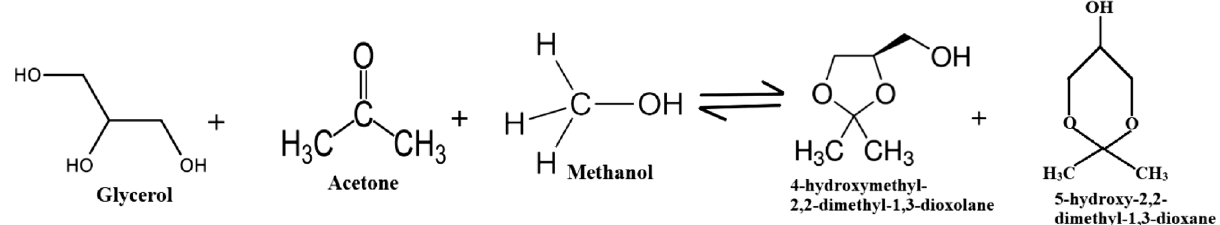
Figure 1. Ketalization reaction for the production of ketals from